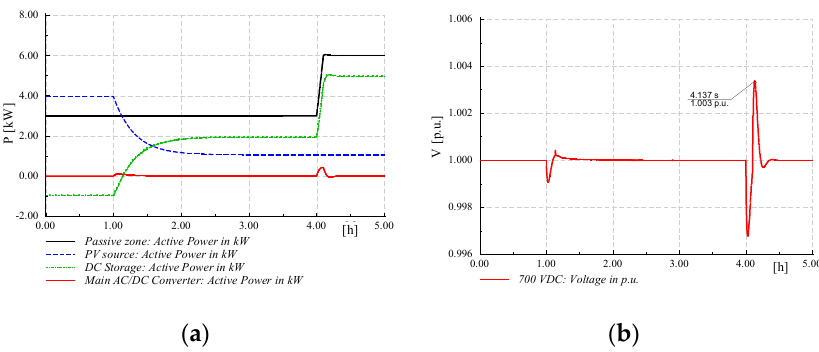
Figure 10. Storage management aiming to reduce power exchange with the network: ( a ) Power flows; ( b ) Voltage of bus 700_VDC .